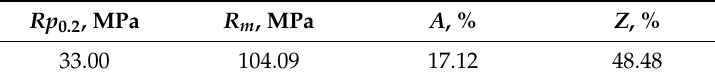
Table 2. Mechanical properties of the investigated